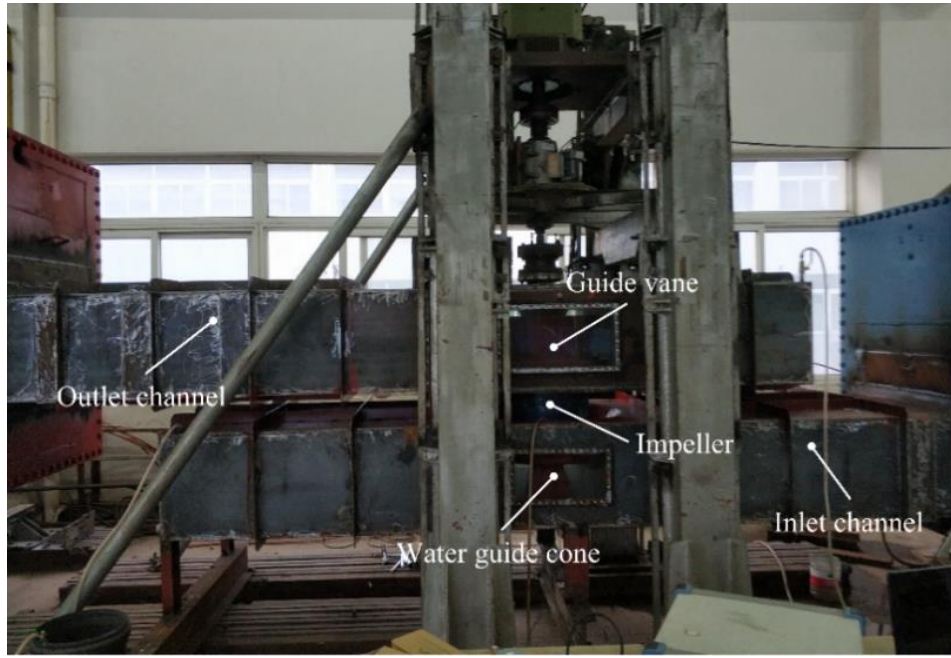
Figure 8. Model test device.